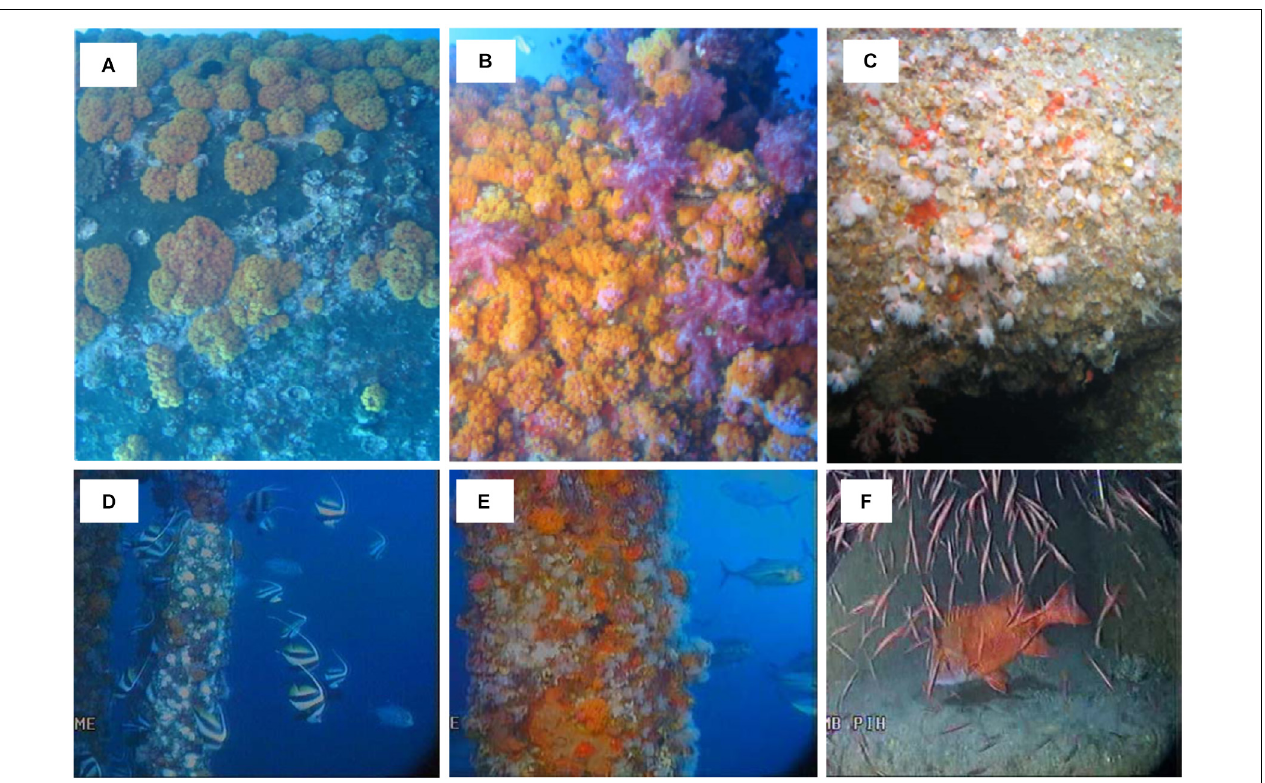
FIGURE 2 | Attached invertebrates on Goodwyn Alpha platform and associated fishes, including (A) the white calcite encrusting layer with bleached bivalves and the hard coral Tubastrea sp. 2, (B) the soft coral Nephthea spp. with the orange hard coral Tubastrea sp. 2, (C) true anemones, sponges and the filamentous layer, (D) bannerfish ( Heniochus sp.), (E) trevally ( Caranx spp.) and (F) a school of unidentified juvenile fish and a red emperor ( Lutjanus sebae ).